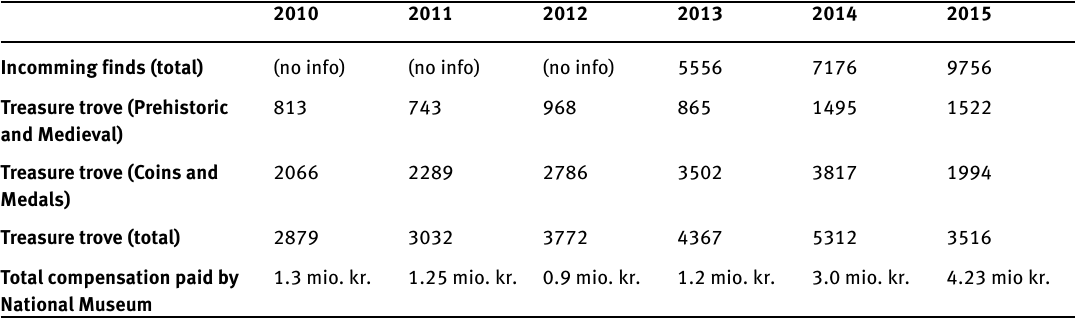
Table 1: Development of incoming finds and treasure trove finds (Treasure trove) at the Danish National Museum registered in the museum’s collection database/protocols. Because the numbers include all treasure trove, they include a small percentage of arti-